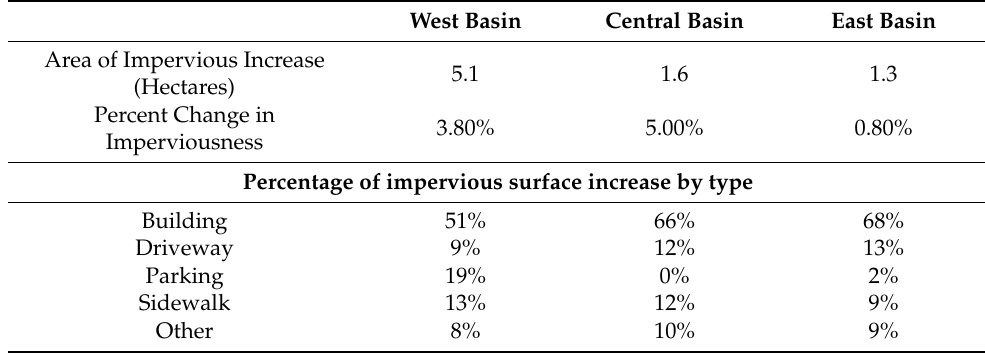
Table 4. Impervious surface increases by basin from 2004 to 2018. “Percentage of impervious surface increase by type” refers to the percentage of total impervious coverage change broken down by what type of new development caused the increase.